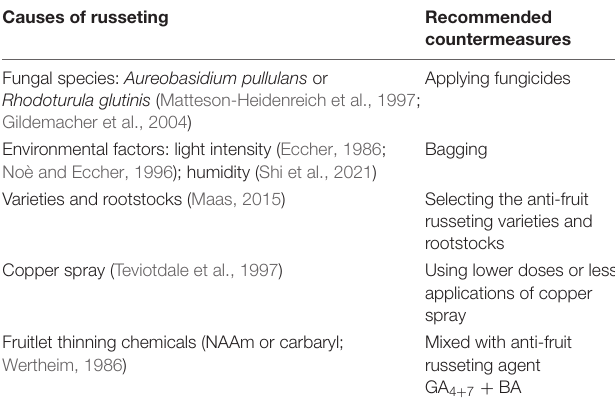
TABLE 1 | Causes of russeting and countermeasures. Causes of russeting Recommended